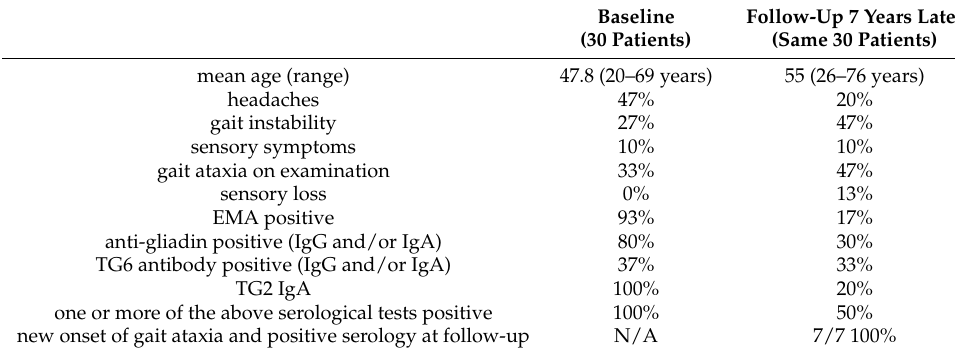
Table 1. Clinical and serological characteristics of the 30 patients that participated in the follow-up study both at baseline and at